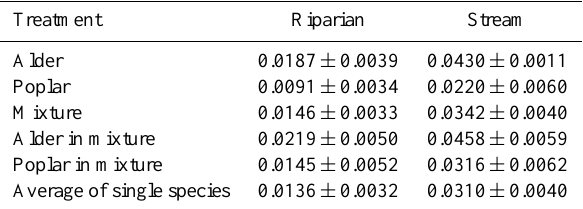
Table 1. Exponential breakdown rates ( − k day − 1 ± 95% confi- dence limits) of leaves of alder, poplar and mixture, of alder and poplar in mixture, and calculated on basis of the average of single- species treatments, decomposing in the stream and at the riparian zone of Ribeira do Botão. N = 9, except for alder in stream where N = 8; r 2 ≥ 0 . 85, p <0.0001.